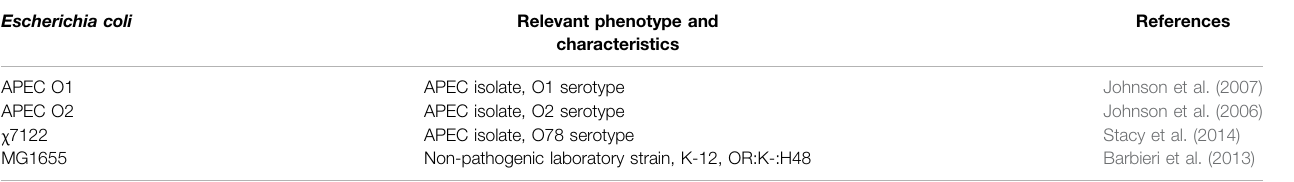
TABLE 1 | Summary of Escherichia coli isolates used for in vitro resistance